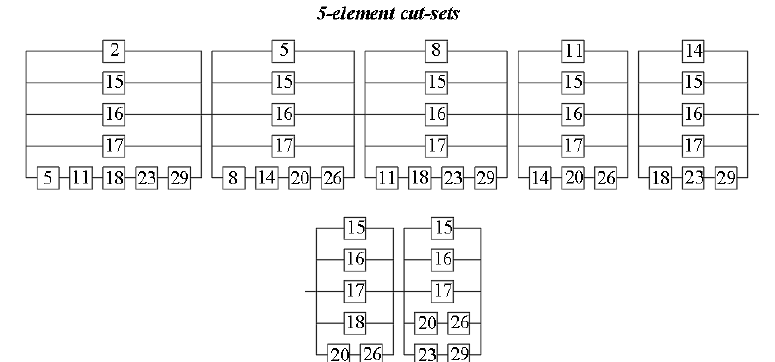
The 2nd change of the static scheme: